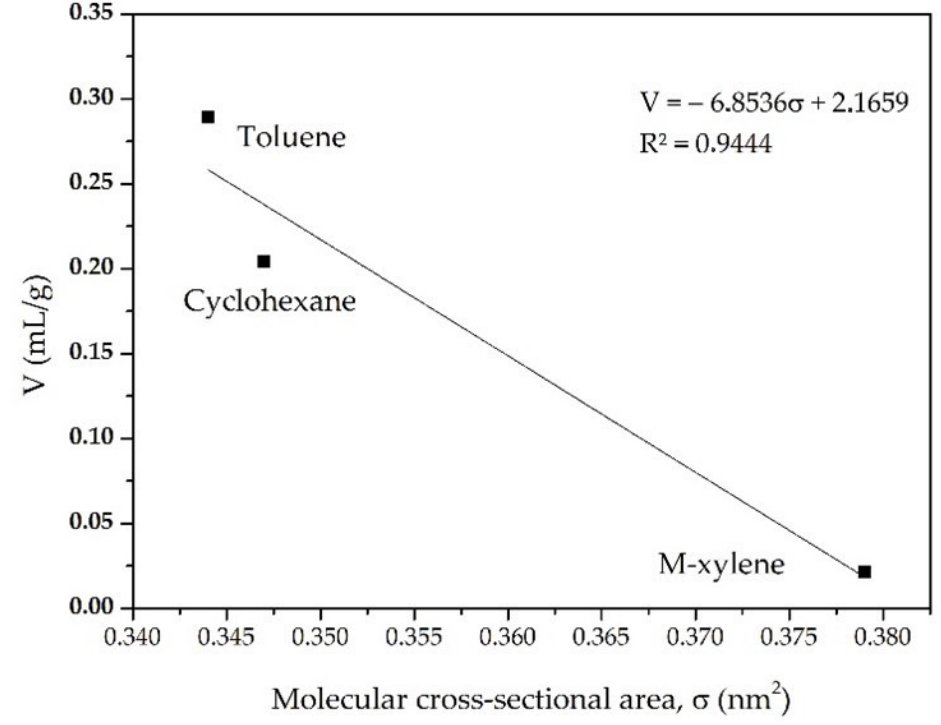
Figure 12. Volume adsorption capacity (V) of VOCs on MOF CIM-80 versus the molecular cross- sectional areas ( σ ) of VOCs.